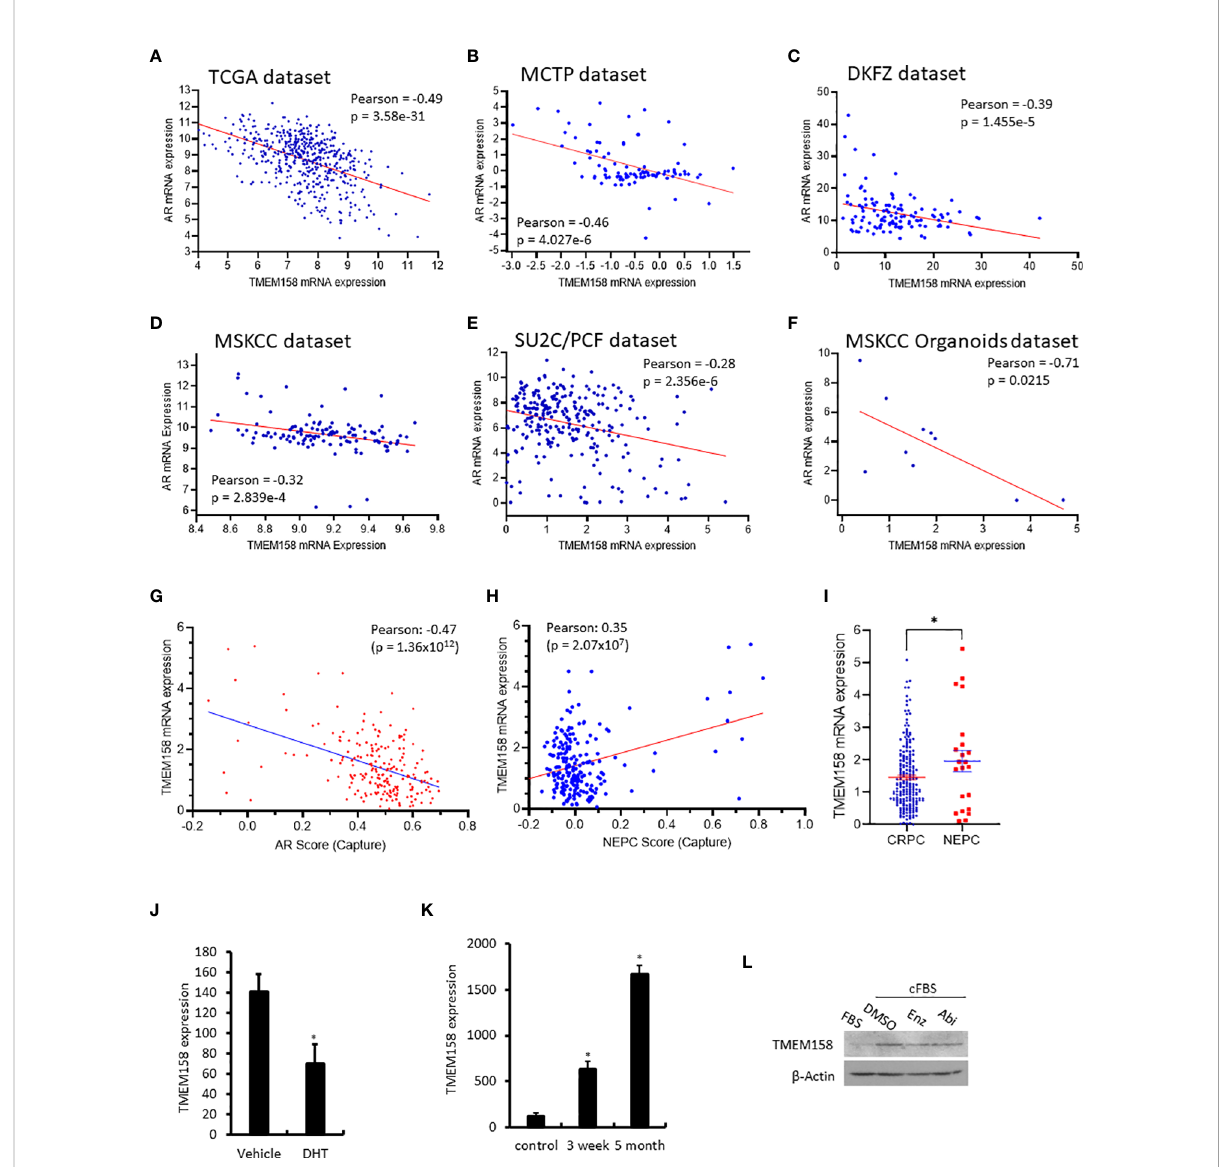
FIGURE 4 TMEM158 downregulation is associated with AR signaling activity in CRPC cancers. (A – F) Pearson correlation analysis was conducted between the expression levels of AR and TMEM158 genes using the RNA-seq data from previously published datasets, as indicated in the fi gures. (G – I) Spearman correlation analysis of TMEM158 expression with the AR activity score (G) and NEPC score (H) , as well as the group comparison of TMEM158 expression between CRPC and NEPC tumors (I) , were conducted using the RNA-seq dataset (24) obtained from 429 patients with metastatic castration-resistant prostate cancers (Student t-test, *p < 0.05). (J – K) TMEM158 expression cDNA microarray datasets were extracted from NCBI GDS2057 (J) (27) and GDS3358 (K) (28). Brie fl y, LNCaP cells were treated with dihydrotestosterone (DHT, 10 nM) or kept in androgen- depleted media for 3-week or 5-month. Total RNAs were extracted for gene expression analysis using the Affymetrix Human Genome U133 Plus 2.0 Array. The asterisk indicates a signi fi cant difference from the vehicle or control culture condition (Student t -test, *p < 0.05). (L) LNCaP cells were exponentially grown in culture media supplied with 10% FBS or in 2% charcoal-stripped FBS. Cells were also treated with anti-AR agents Enzalutamide (Enz, 10 m M) or Abiraterone (Abi, 10 m M) in 2% charcoal-stripped FBS for 24 h. Cellular proteins were used for the anti-TMEM158 immunoblot assay. Action blot served as a protein loading